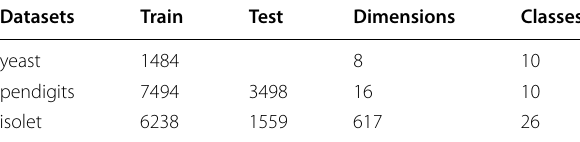
Table 3 Basic information about three real data sets: protein localization sites (yeast), pen-based recognition of